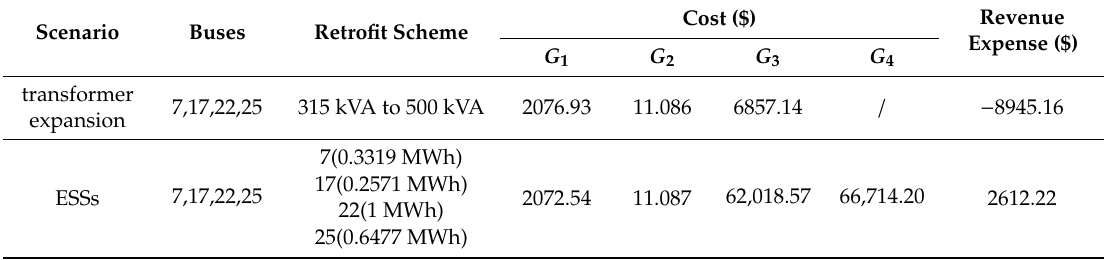
Table 2. Analysis of economic optimization configuration of an expansion-transformed energy storage system.